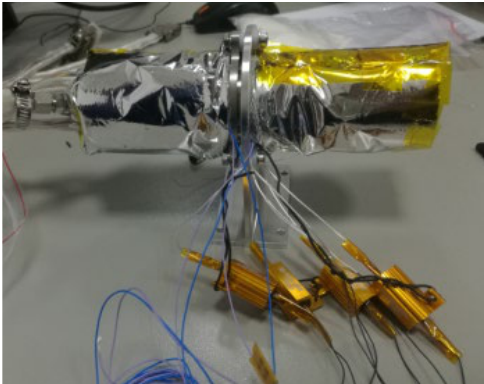
Figure 7. Thruster with thermal control coating.